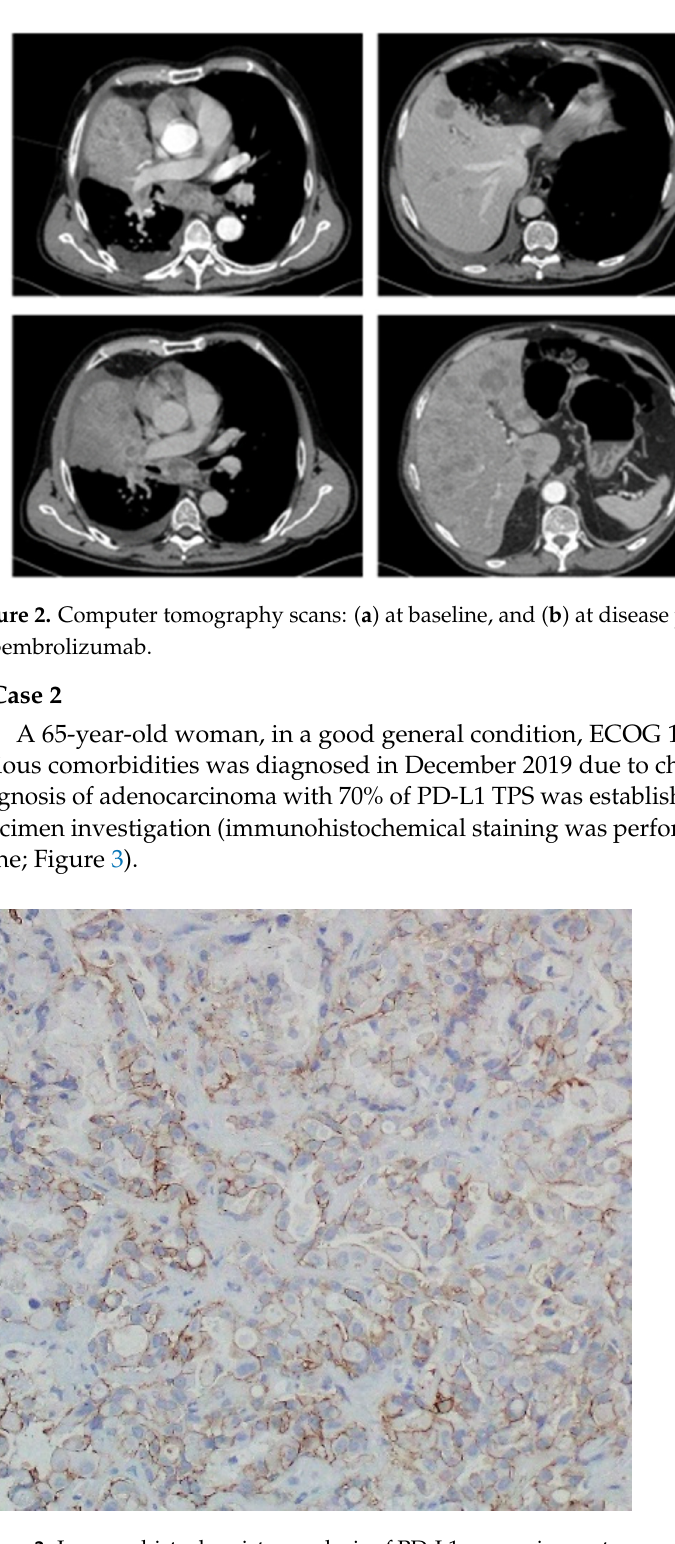
Figure 3. Immunohistochemistry analysis of PD-L1 expression on tumour cells using 22C3 anti-PD-L1 antibody (DAKO) (PD-L1 TPS—70%).